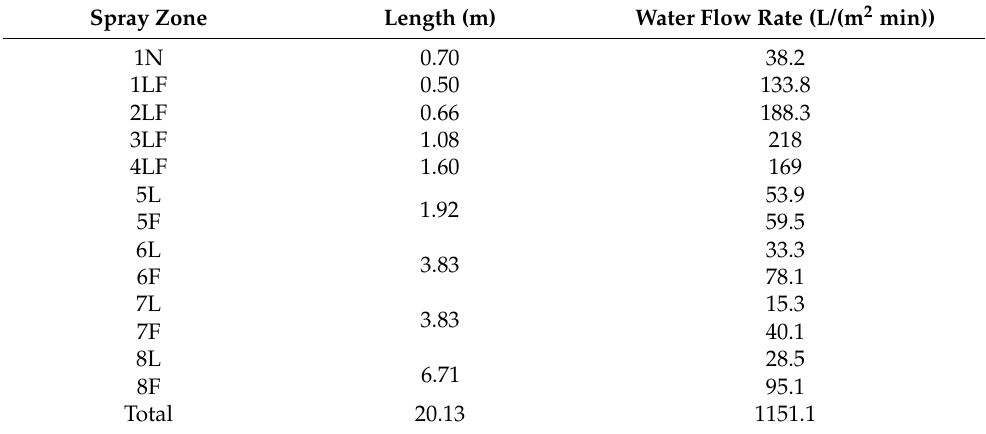
Table 6. Length and water flow rate for different secondary cooling zones used in the calculation. Spray Zone Length (m) Water Flow Rate (L/(m 2 min))